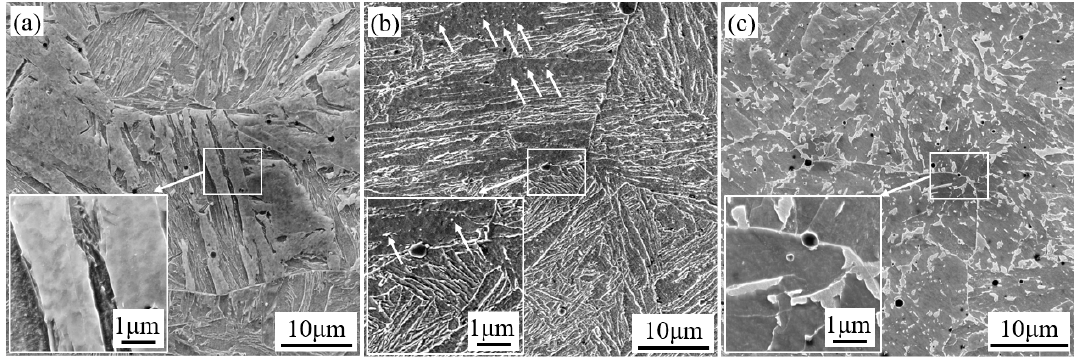
Figure 2. SEM graphs of three specimens at various cooling rates: ( a ) water-quenching; ( b ) 5 °C/s; ( c ) 0.05 °C/s.